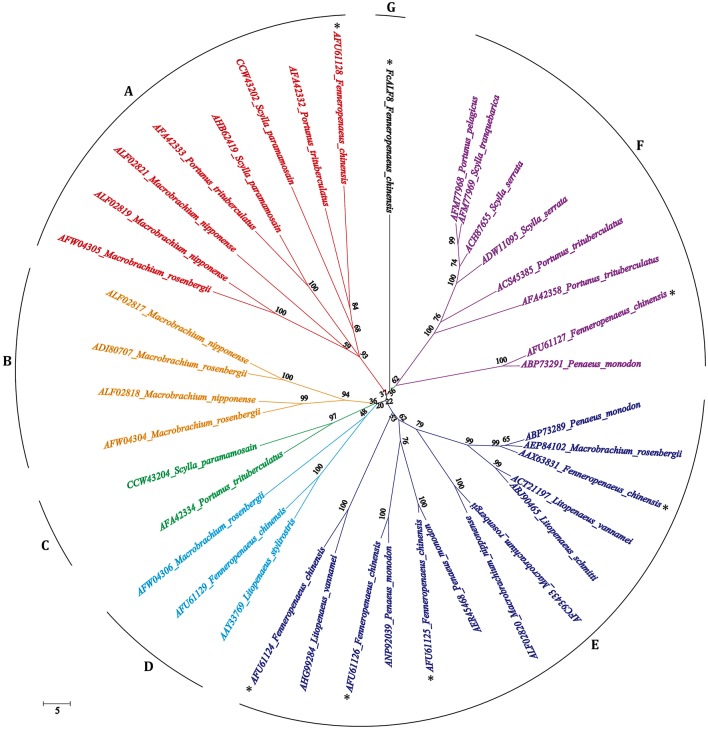
Bootstrapping phylogenetic analyses of anti-lipopolysaccharide factors (ALFs) from twelve crustacean species. The ALFs were showed with GenBank accession numbers listed in Table 2. Whole deduced amino acid sequences excluding signal peptide of ALFs were used for phylogenic analysis by Neighbor-Joining. Bootstrap value was set at 1,000. Percentage of bootstrap replications and divergence distance were shown in the figure. The branches of different type ALFs (with <40% of bootstrap replications) were shown with different colors and capital letters (A–G). ALF sequences from F. chinensis were marked with a star (*).